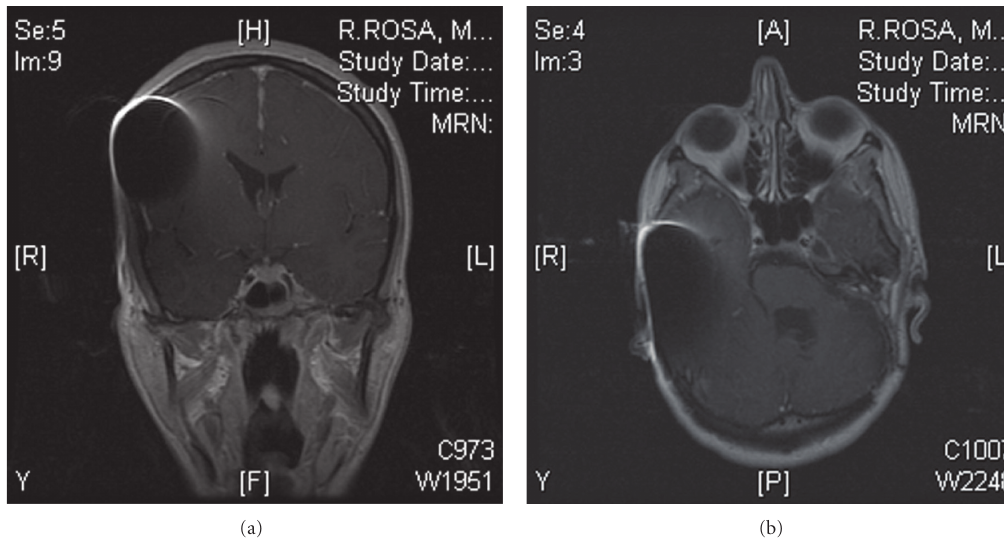
Figure 2: MRI followup at 1.5 T of a patient with surgically removed VS and cochlear implantation (Pulsar CI 100,